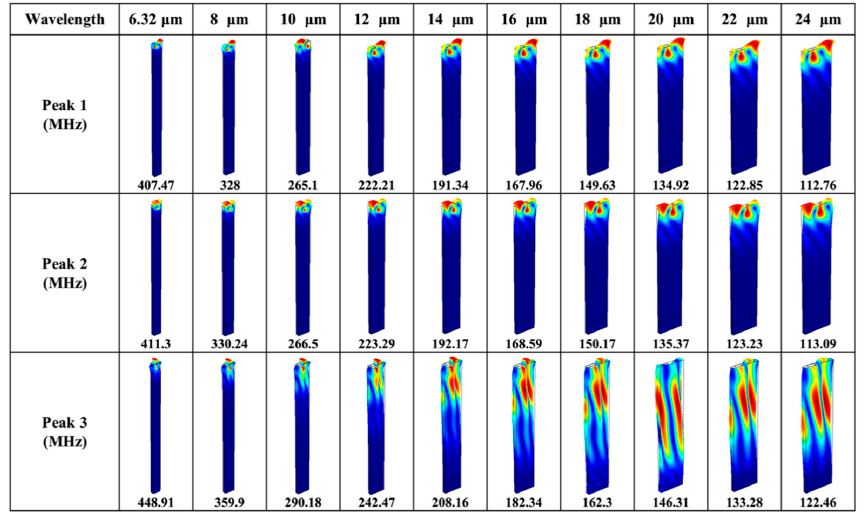
Figure 4. Vibration shapes of Peak 1, 2 and 3 as a function of wavelength in the range from 6.32 to 24 μm of Device A.